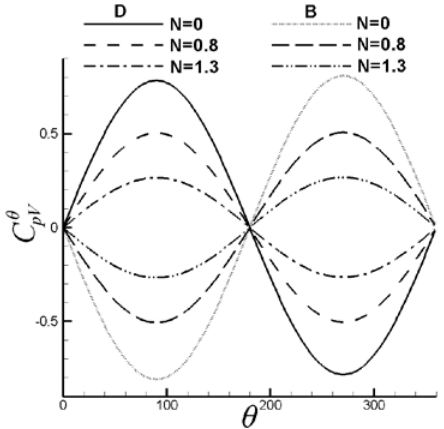
Figure 10. Distributions of interaction parameter N C θ .